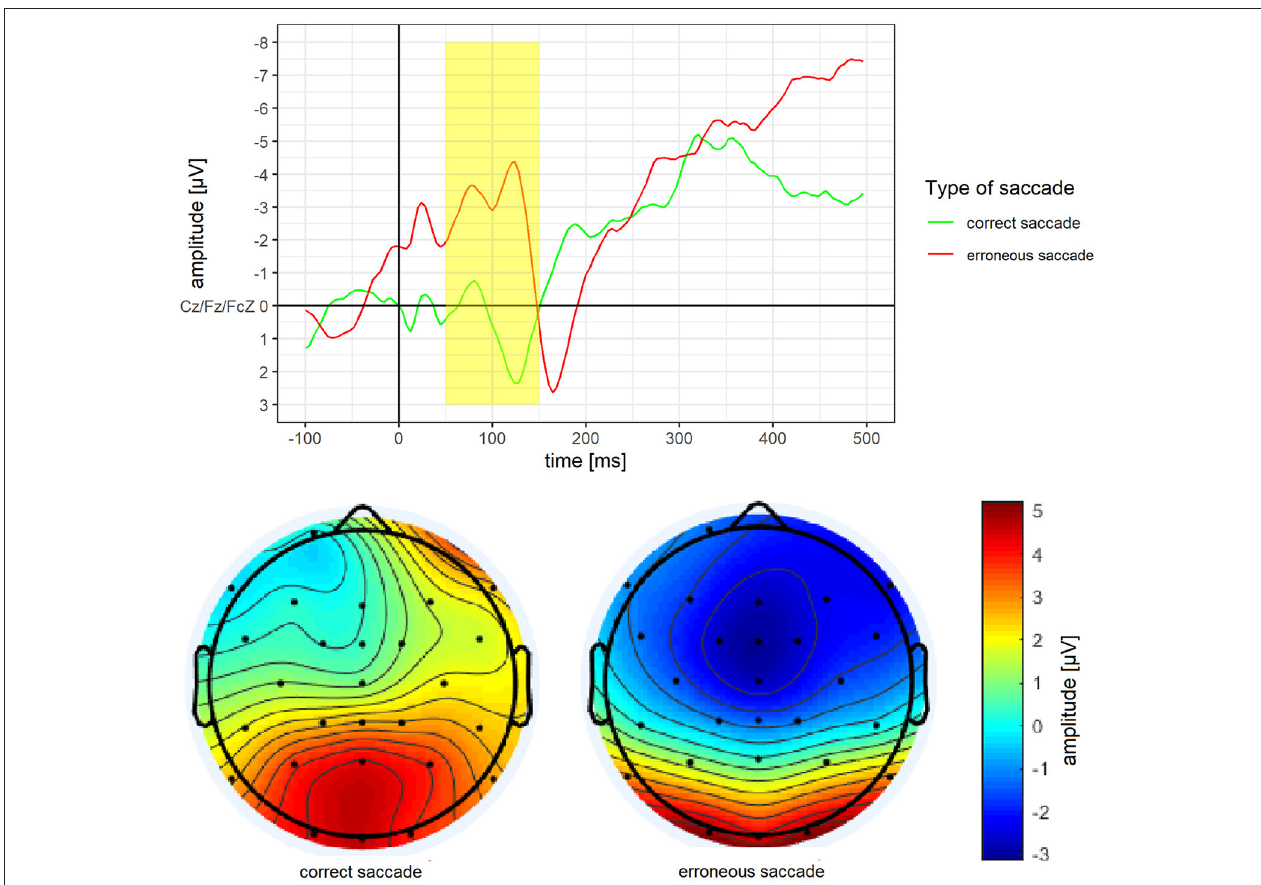
FIGURE 4 | Grand average difference wave of the ERN separately for erroneous and correct saccades. Underneath a scalp map displaying the mean voltage distribution for erroneous and correct saccades in the time window ranging from 50 to 150ms after saccade onset. saccades at T0 ( r = − 0.64, p = 0.007), T1 ( r = − 0.65, p